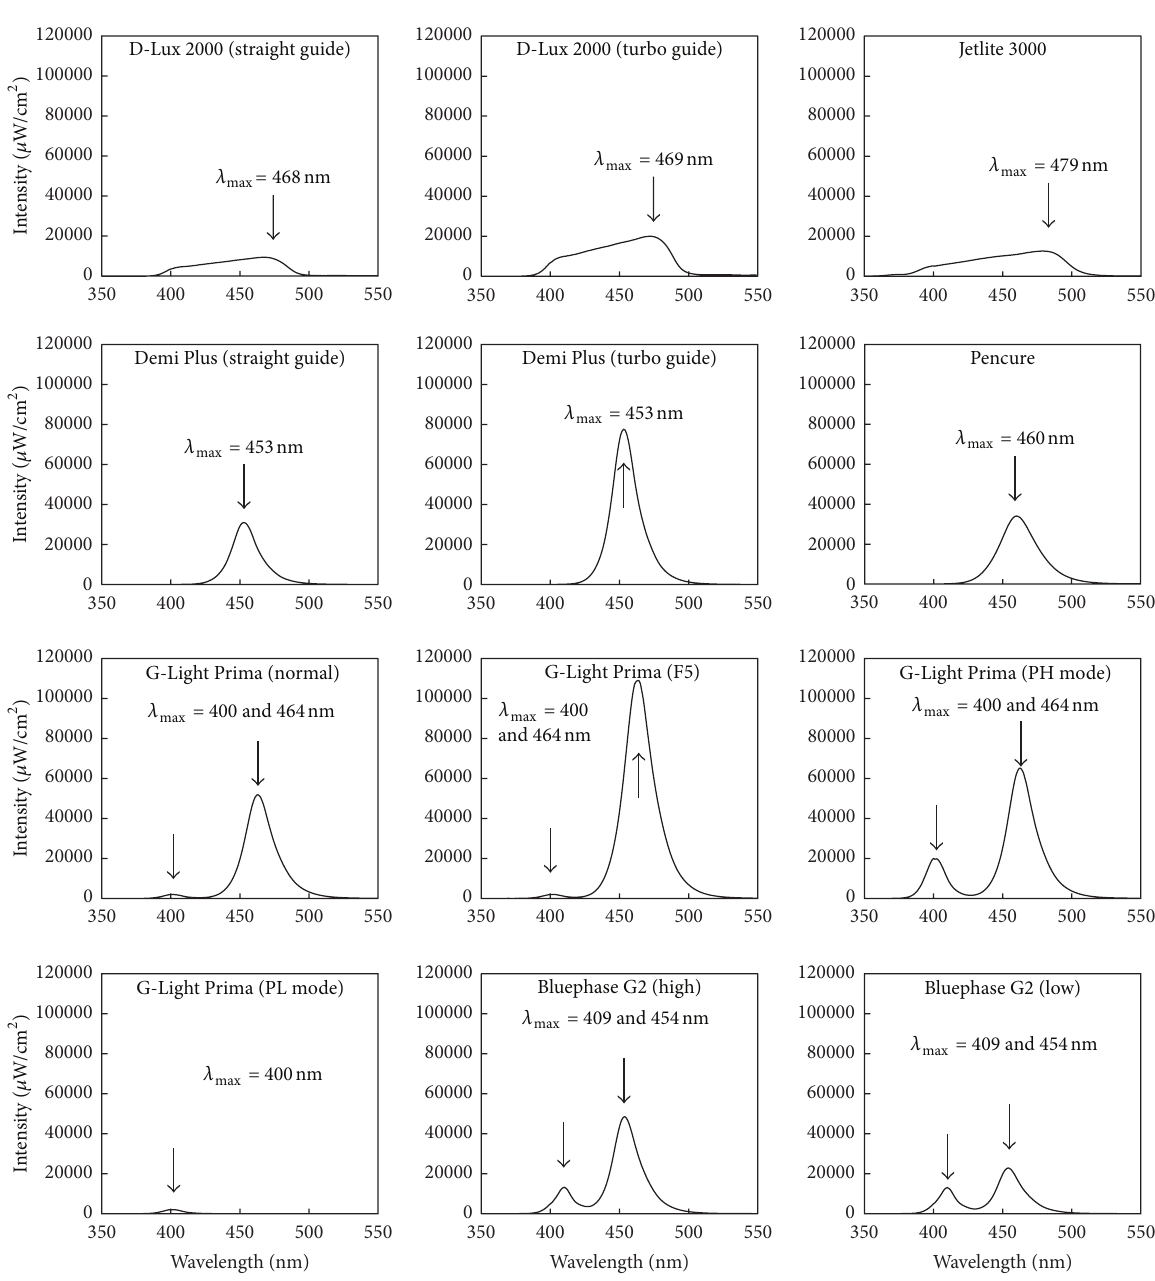
Figure 1: Spectral distributions of the 12 curing light sources used in this